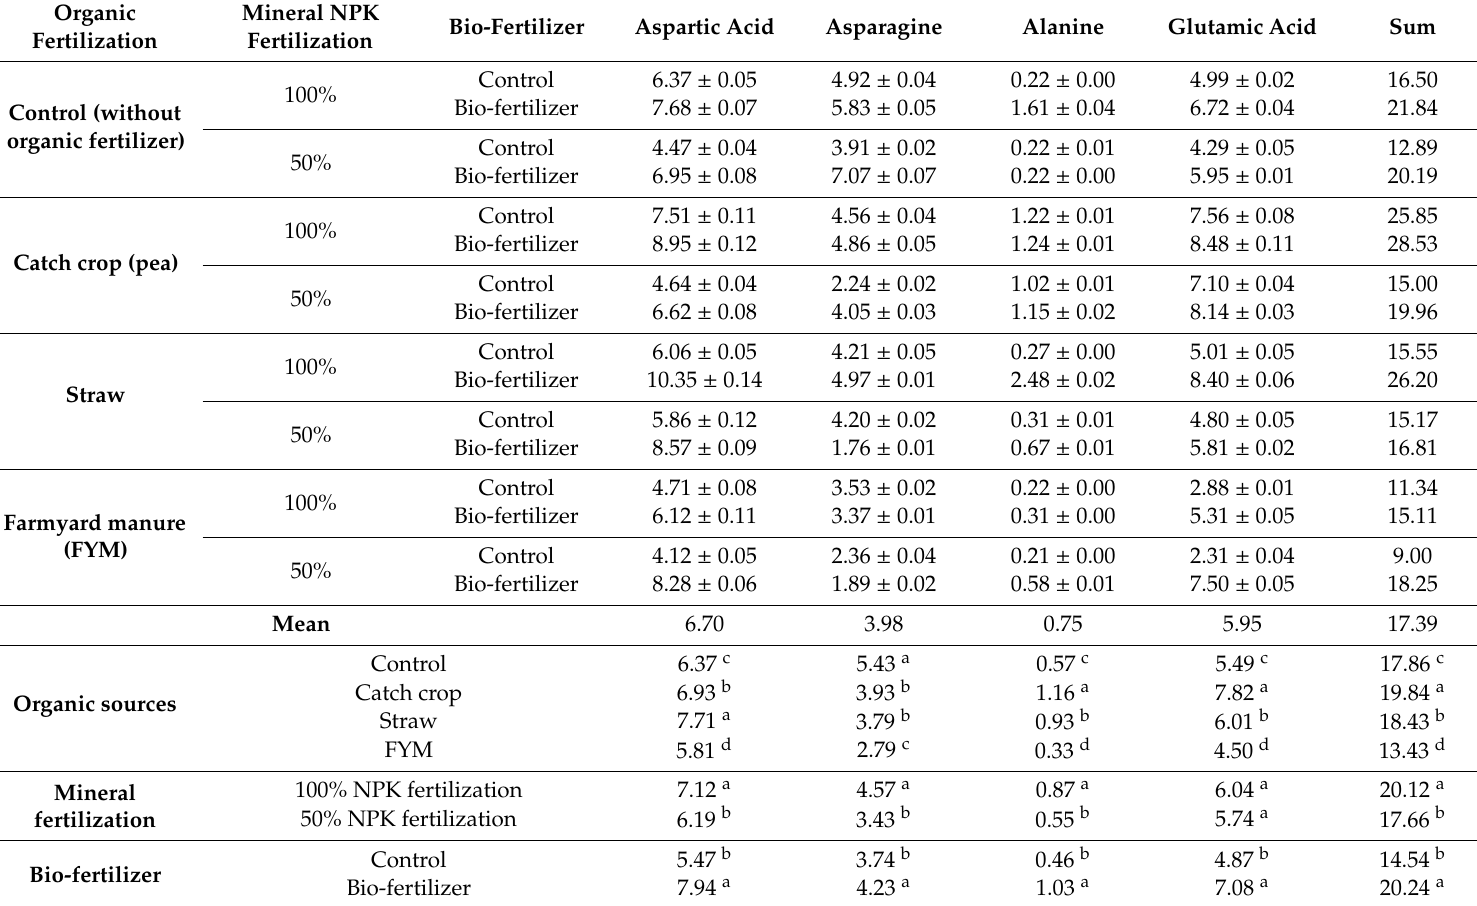
Table 8. Non-essential amino acids content (g 100 g − 1 protein) in potato tubers. Mean for three years of